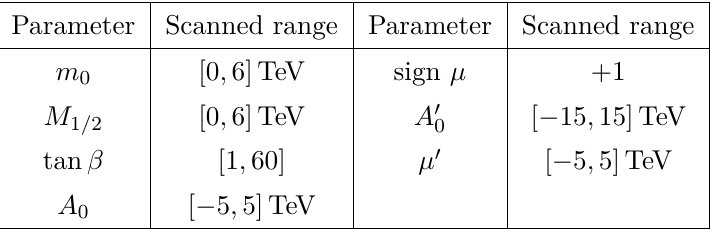
Table 1 . Scanned parameter